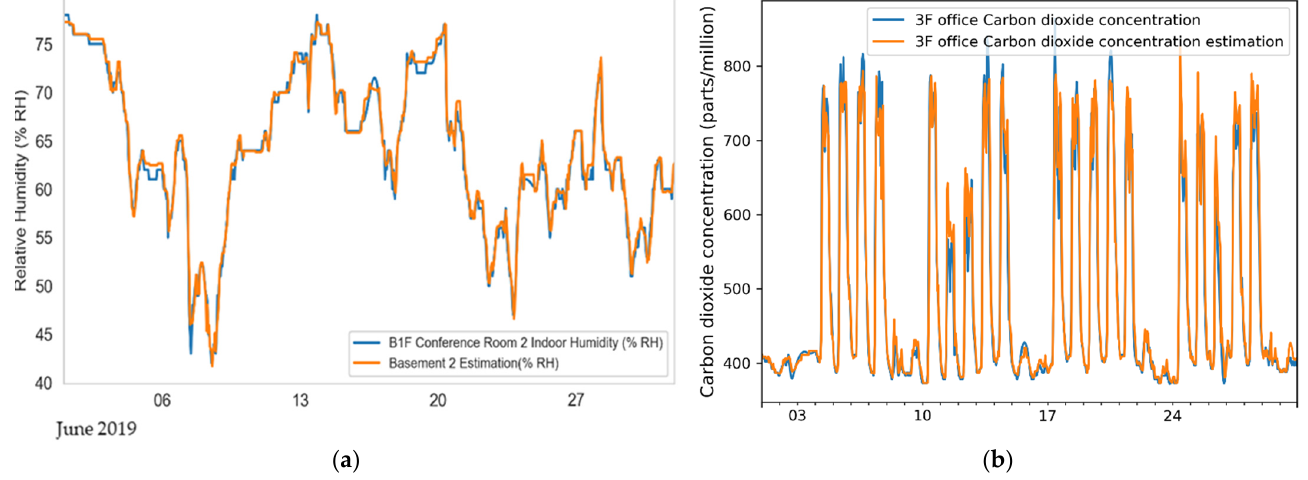
Figure 7. ( a ) Plot of actual B1F conference room 2 relative humidity and its estimation for June 2019; ( b ) plot of actual 3F office room CO 2 concentration and its estimation for June 2019. Table 3. Performance evaluation metrics results for relative humidity and CO 2